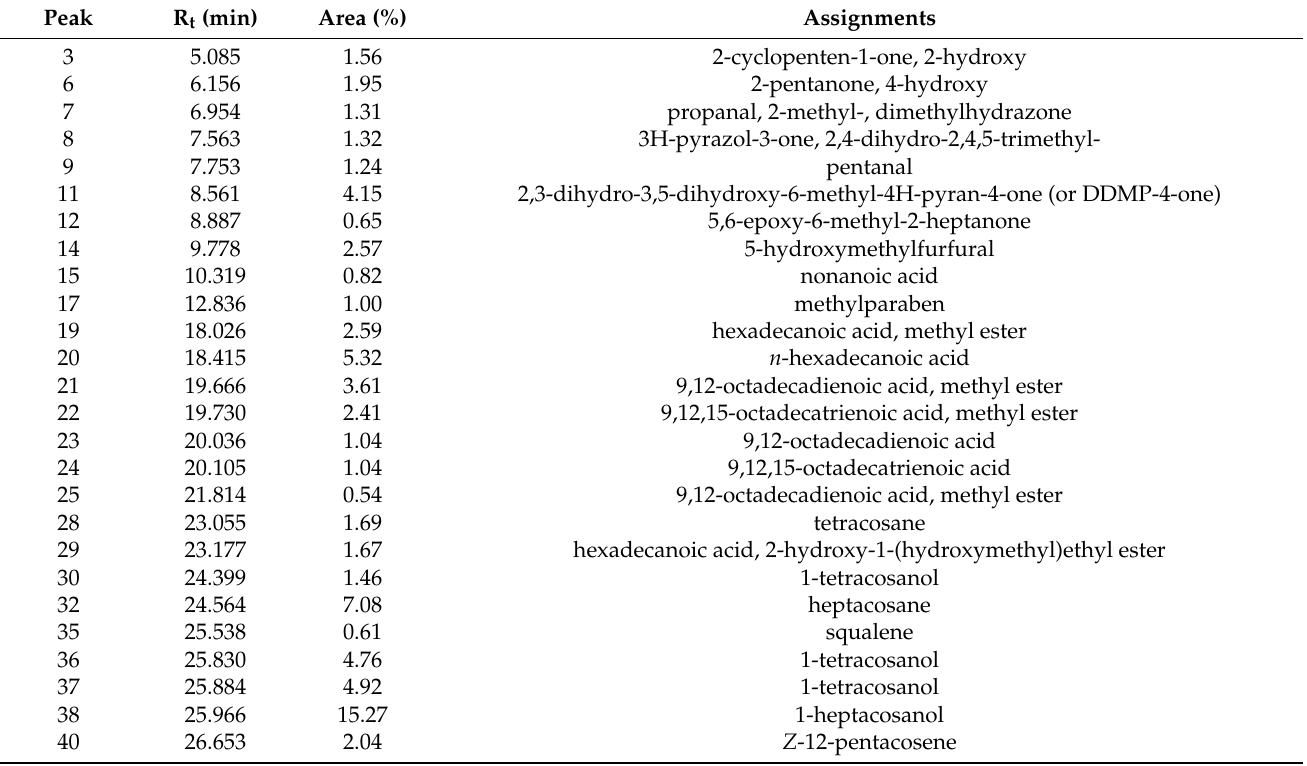
Table 3. Main compounds identified in Hibiscus syriacus flower hydromethanolic extract by